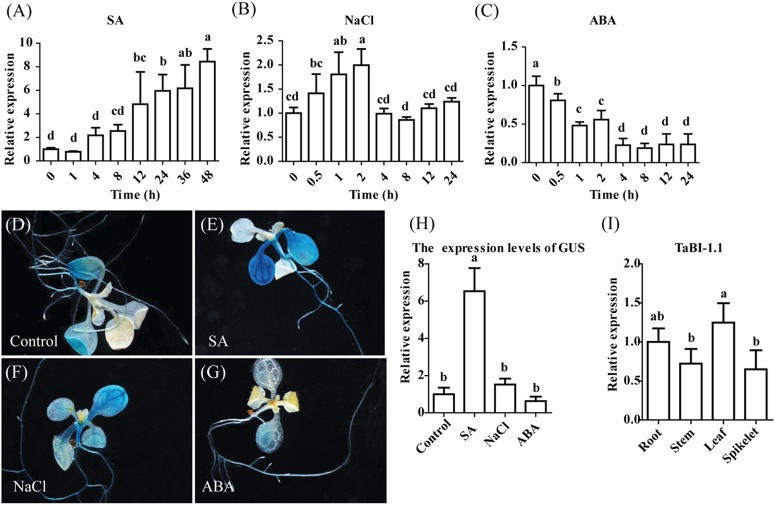
Relative and spatial expression patterns of TaBI-1.1 were evaluated by qRT-PCR and GUS staining. qRT-PCR analysis showing relative expression of TaBI-1.1 in the wheat seedlings with SA (A), NaCl (B), and ABA (C) treatments. The vertical coordinates represent fold changes, and the horizontal coordinates represent time. Wheat actin was used as a reference. (D–G) GUS staining for TaBI-1.1 expression in seedlings grown in the presence of SA, NaCl and ABA treatments. Seedlings grown under normal condition were used as the control. (H) qRT-PCR analysis of GUS expression levels in the PBI:GUS transgenic lines. The vertical coordinates represent fold changes, and the horizontal coordinates represent different treatments. Arabidopsis actin2 was used as a reference. (I) qRT-PCR analysis of the transcript levels of TaBI-1.1 in roots, stems, leaves, and spikelets wheat tissues. The vertical coordinates represent fold changes, and the horizontal coordinates represent different tissues. Wheat actin was used as a reference. Three biological replicates were taken for qRT-PCR. Error bars indicate standard deviations (SDs). All the data represent the means ± SDs of three independent biological replicates. Different letters in bar graphs indicate significant differences.